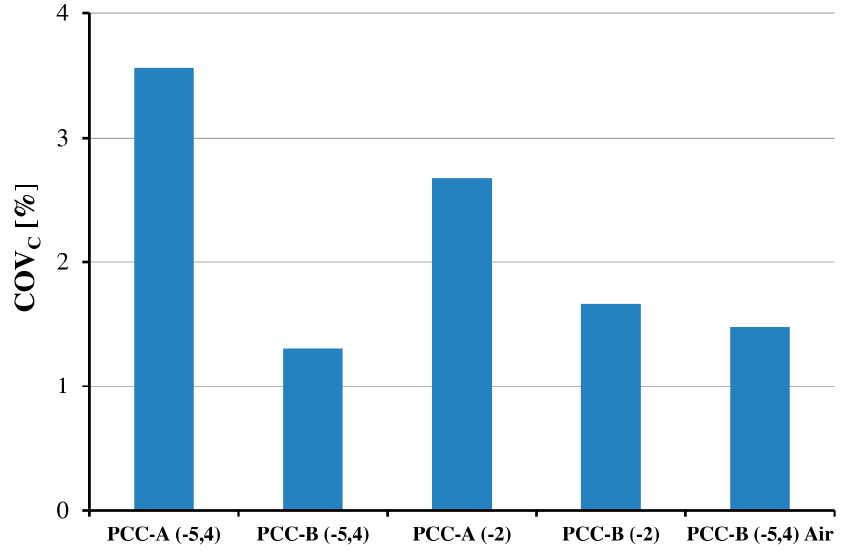
Figure 9. Combustion stability (COV C ) versus ignition time.